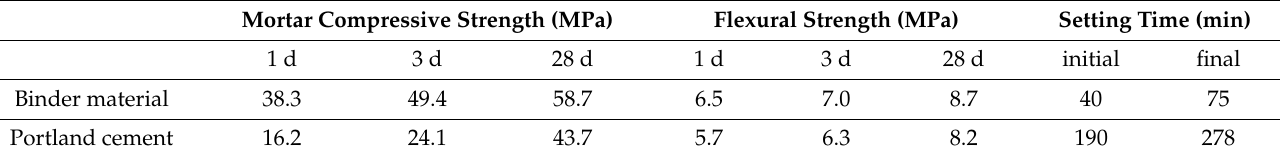
Table 6. Physical and mechanical performance of binder materials and Portland cement. Mortar Compressive Strength (MPa) Flexural Strength